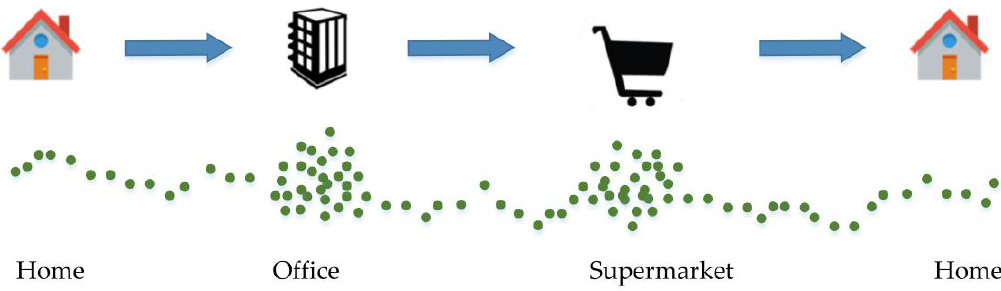
Figure 1. An example of a trajectory.